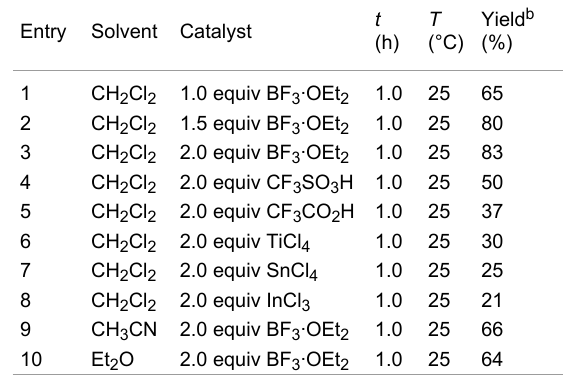
Table 1: Optimization of the intermolecular coupling reaction of 1a with 2a. a Entry Solvent Catalyst